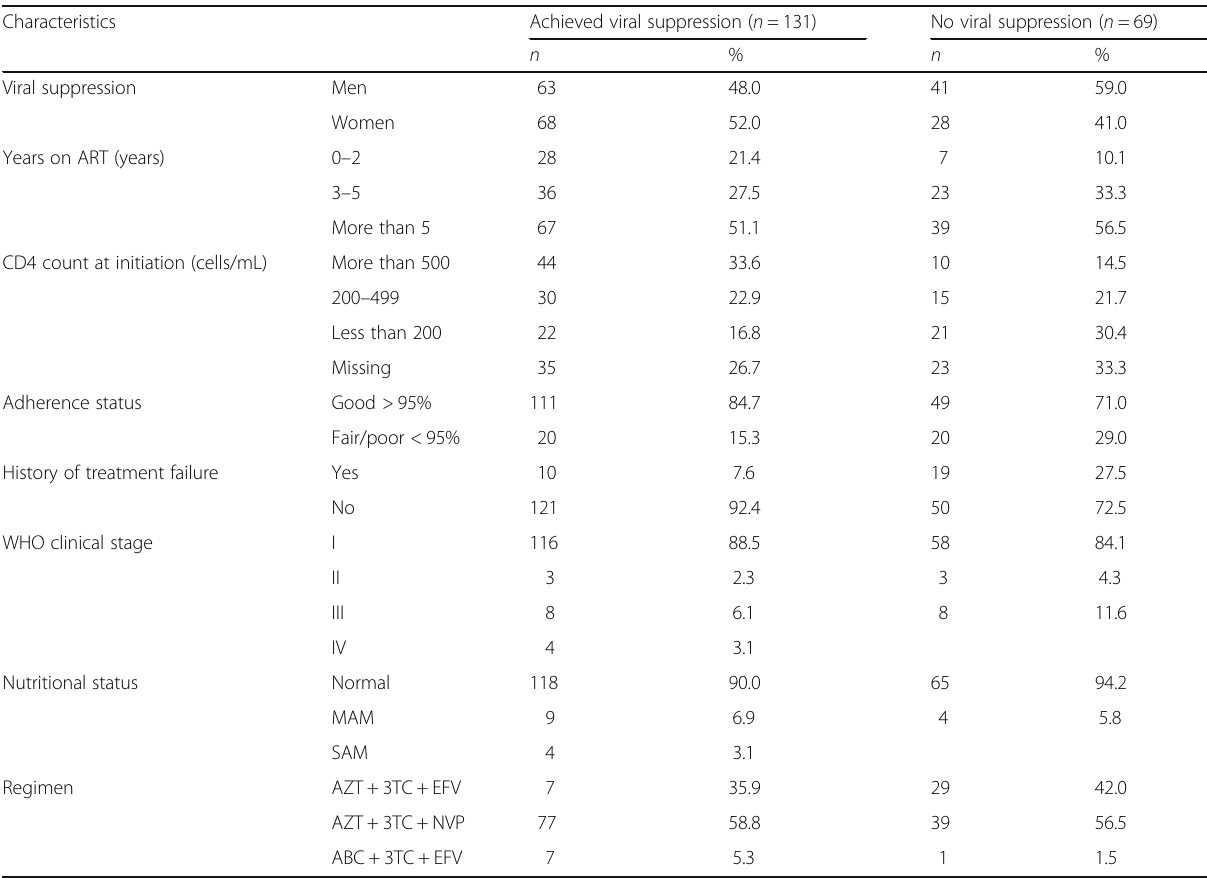
Table 3 Treatment- and health-related characteristics of adolescents and viral suppression Characteristics Achieved viral suppression ( n =